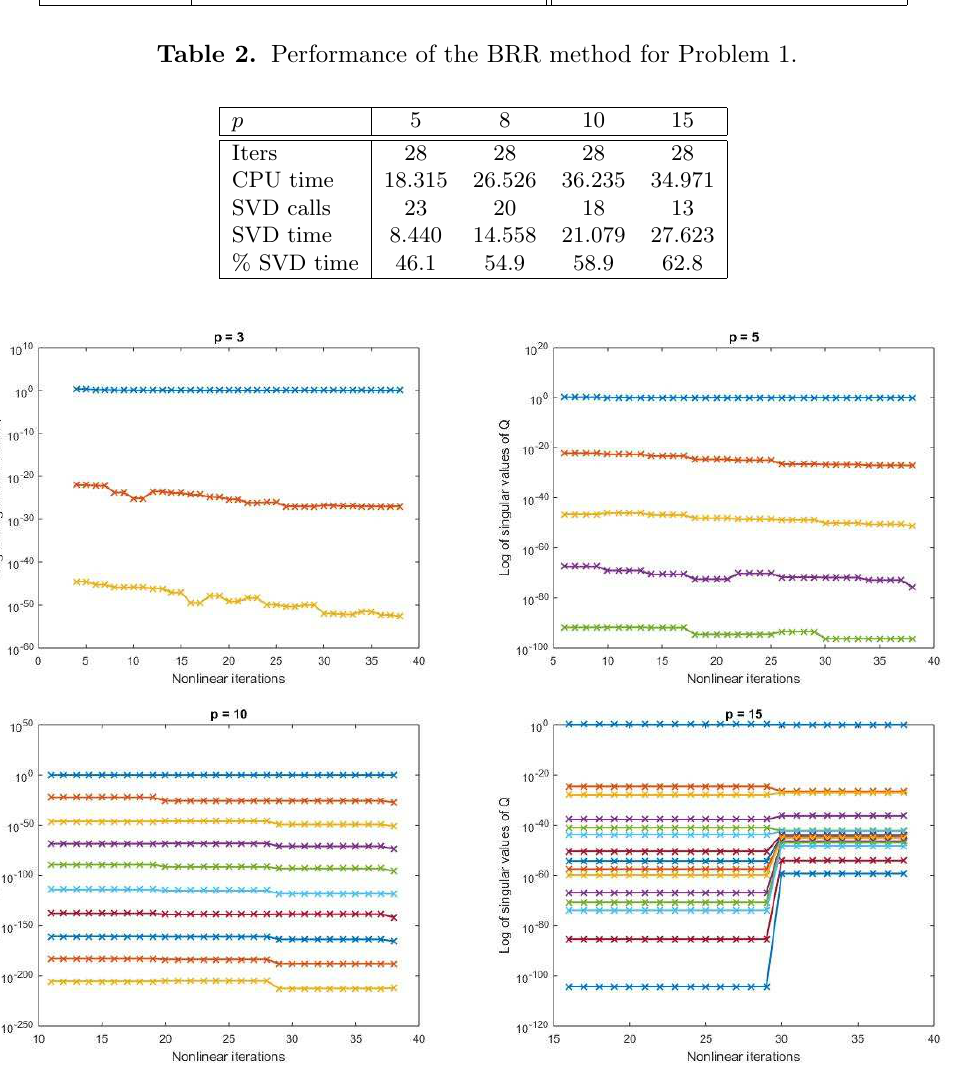
Figure 2. Singular values of the update matrix Q for p = 3 , 5 , 10 and p = 15 for Problem